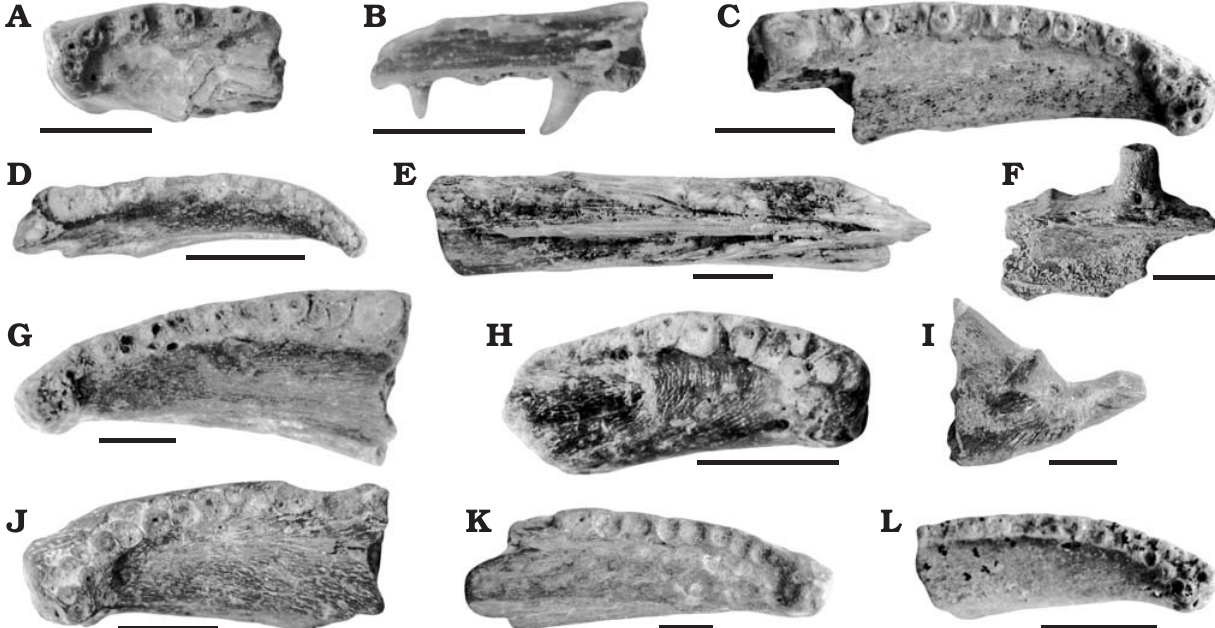
Fig. 2. Isolated elements assigned to a pike Esox sibiricus Sytchevskaya, 1976 from Southeastern Europe; late Miocene (A–J), Pliocene (K), and Pleistocene (L). A . Right dentary (NMNHU-P 29/1679), Popovo 3, occlusal view. B . Dentary fragment with teeth (NMNHU-P 29/1680), Popovo 3, medial view. C . Left dentary (NMNHU-P 29/3965), Lobkovo, occlusal view. D . Left dentary (NMNHU-P 45/5690), Cherevichne 3, occlusal view. E . Parasphenoid (NMNHU-P 29/1033), Verkhnya Krynitsya 2, dorsal view. F . Dentary fragment (NMNHU-P 29/1034), Verkhnya Krynitsya 2, lateral view. G . Right dentary (NMNHU-P 41/4324), Egorovka 2, occlusal view. H . Left dentary (NMNHU-P 41/2847), Orekhovka, occlusal view. I . Right artic- ular (NMNHU-P 41/4525), Egorovka 2, lateral view. J . Right dentary (NMNHU-P 41/2741), Vinogradovka 1, occlusal view. K . Left dentary (NMNHU-P 37/2554), Novopetrovka, occlusal view. L . Left dentary (NMNHU-P 29/1583), Popovo 2, occlusal view. C, D, H, I, K, L, anterior to right; A, B, F, G, J, anterior to left; E, anterior towards top. Scale bars 5